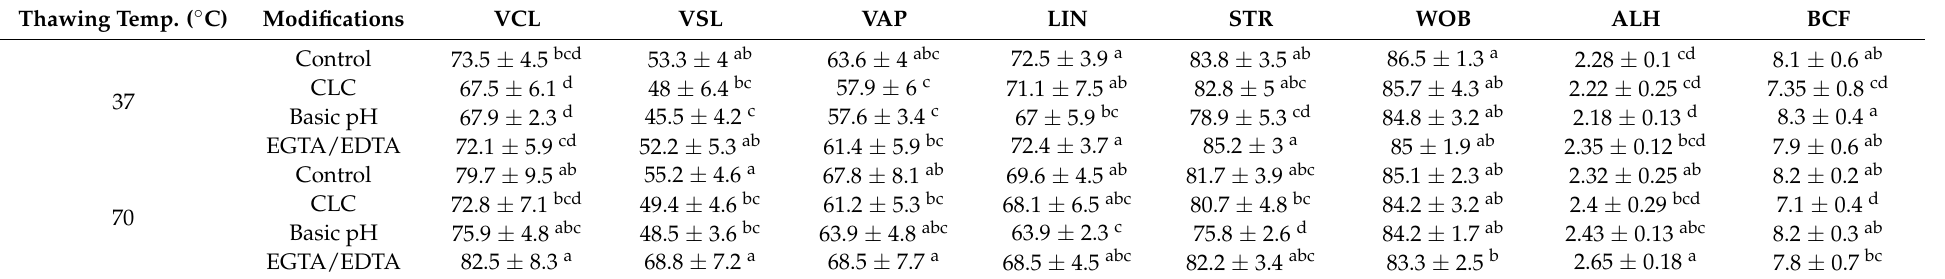
Table 3. Evaluation of different modifications in the thawing extenders: effect on kinematic parameters. Thawing Temp. ( ◦ C)